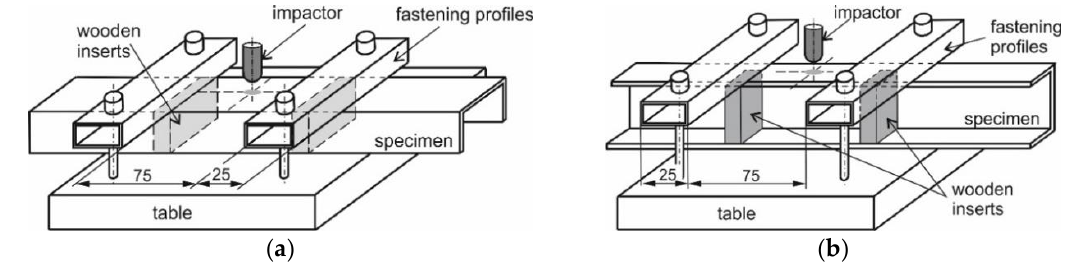
Figure 2. Schemes of profile support in case of impact into web ( a ) and flange ( b ).